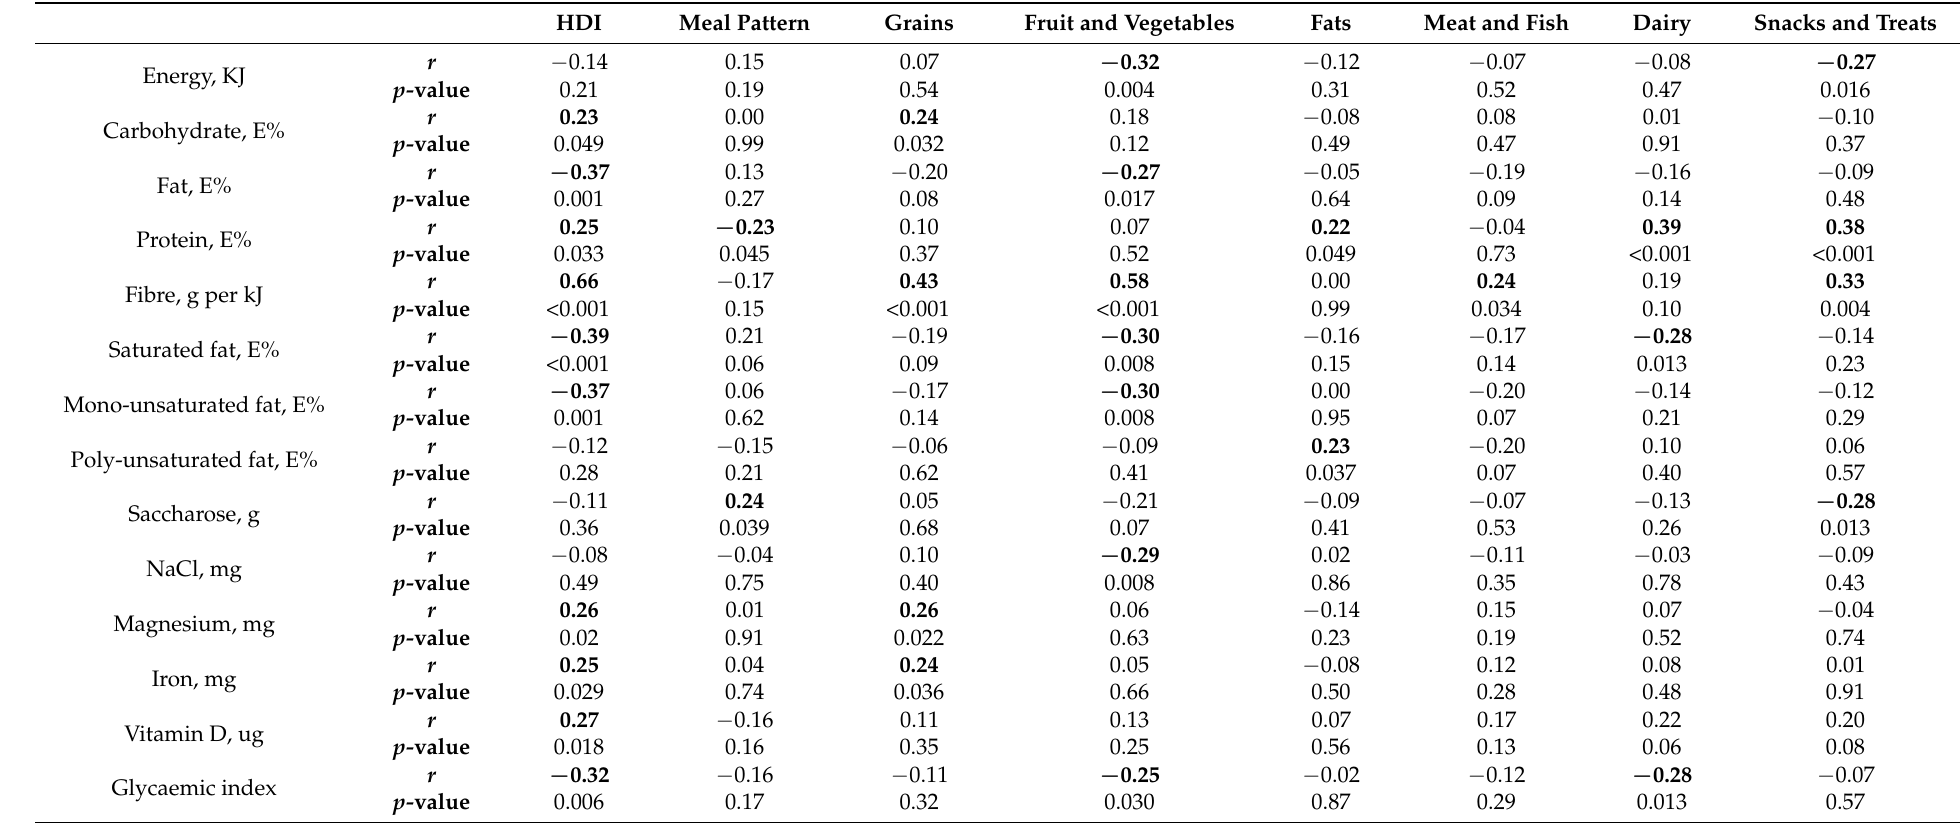
Table 2. Correlation between Healthy Diet Index (HDI) and its domains and dietary intakes calculated from 7-day food records among 77 men and women (the Airline data). HDI Meal Pattern Grains Fruit and Vegetables Fats Meat and Fish Dairy Snacks and Treats Energy, KJ